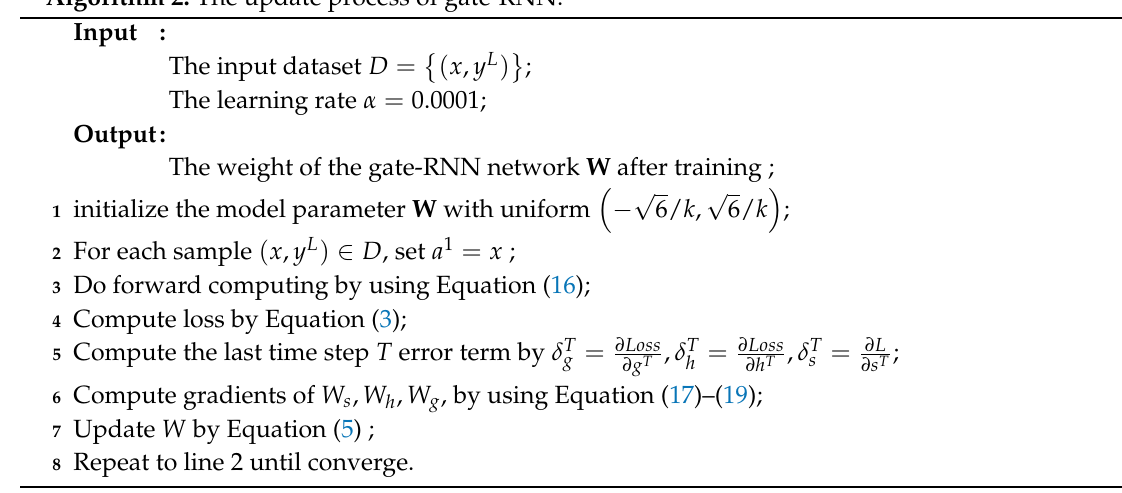
Algorithm 2: The update process of